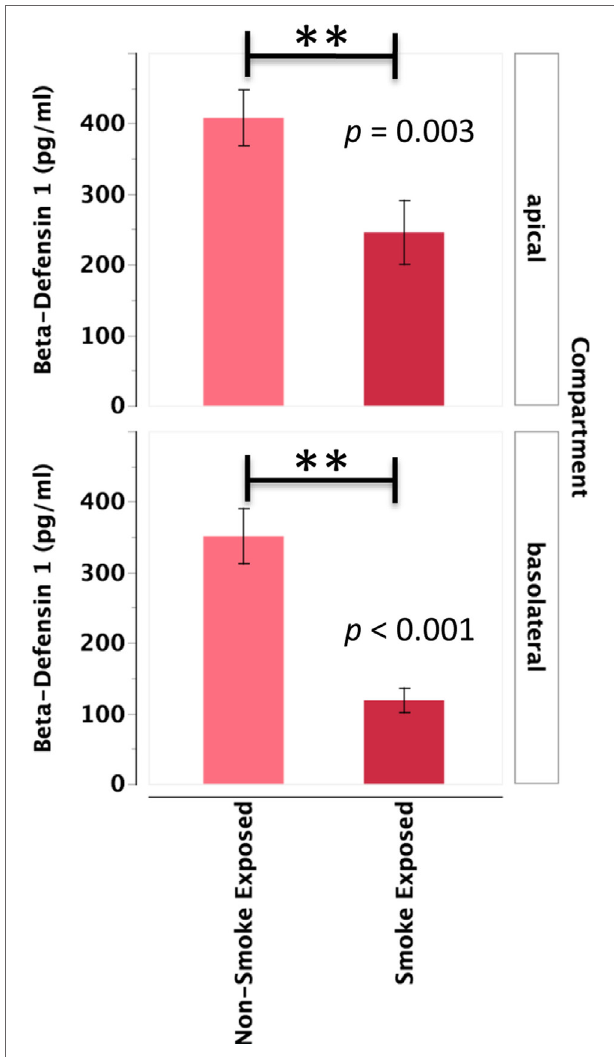
FigUre 4 | Beta-defensin 1 secretion into the apical and basolateral compartments is significantly lower in Phnec from in vivo smoke- exposed individuals. Beta-defensin 1 secretion was not significantly different among the four treatments in our PHNEC experiments. However, there was a significant effect of smoke exposure status and this figure shows secretion data pooled (from all treatments) from every PHNEC secretion